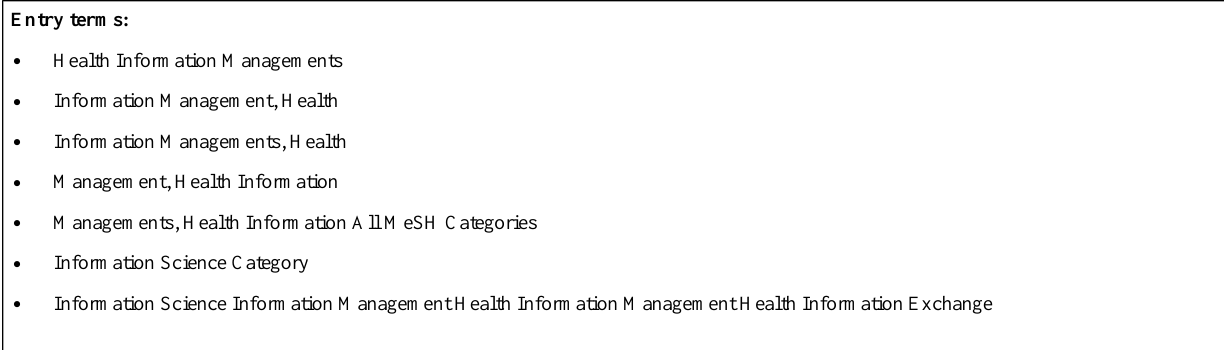
Textbox 2. Medical Subject Headings term search result.